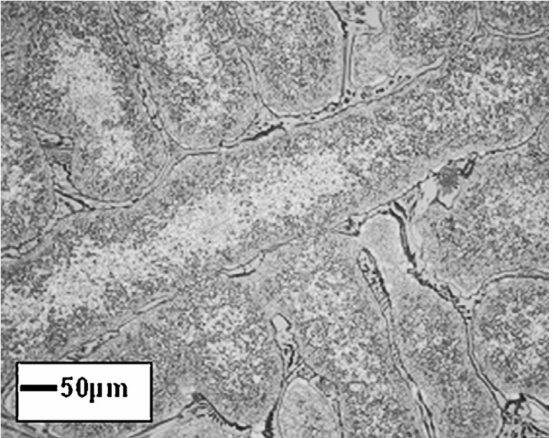
Figure 25. Microstructure of CuTi 3 Sn 2.75 alloy under OM in as-cast condition [67].